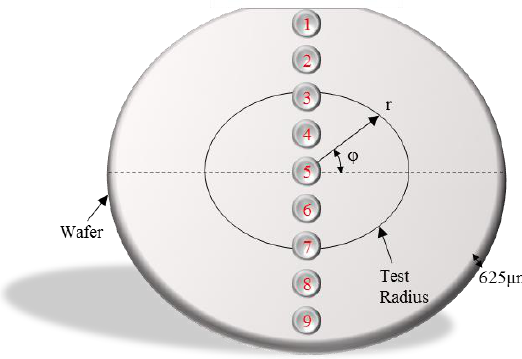
Figure 6. Selected positions for birefringence distribution measurements across the wafer.